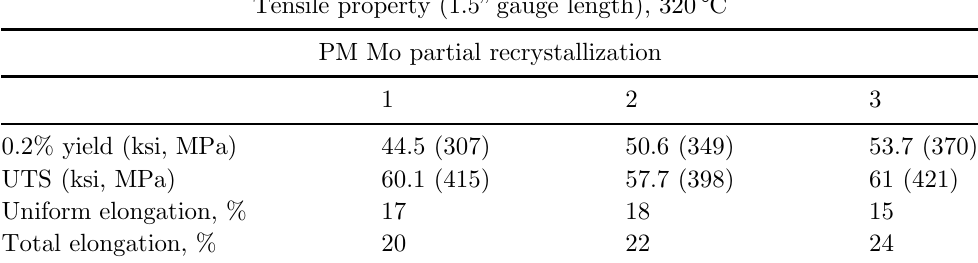
Table 1. Mechanical properties of partially recrystallized Mo-alloy tubes tested at room temperature.